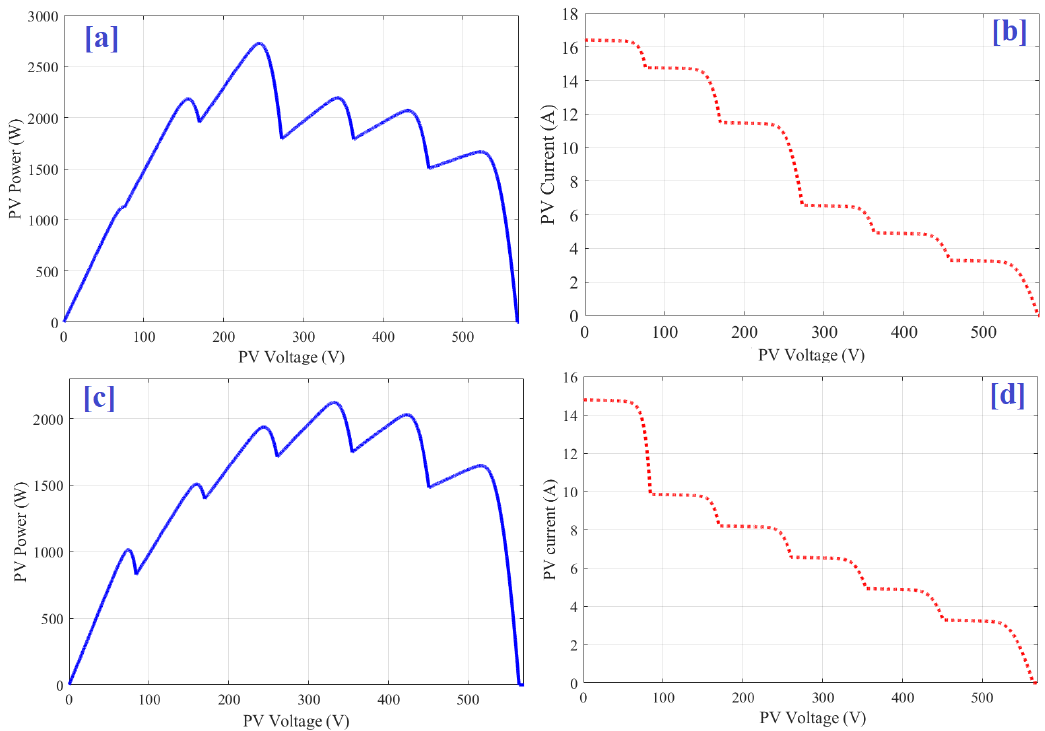
Figure 5. The details of shadow patterns. ( a ) P - V curve first scenario, ( b ) I - V curve first scenario, ( c ) P - V curve second scenario, and ( d ) I – V curve second scenario. Table 5. Specification of shadow patterns and data at MPP.